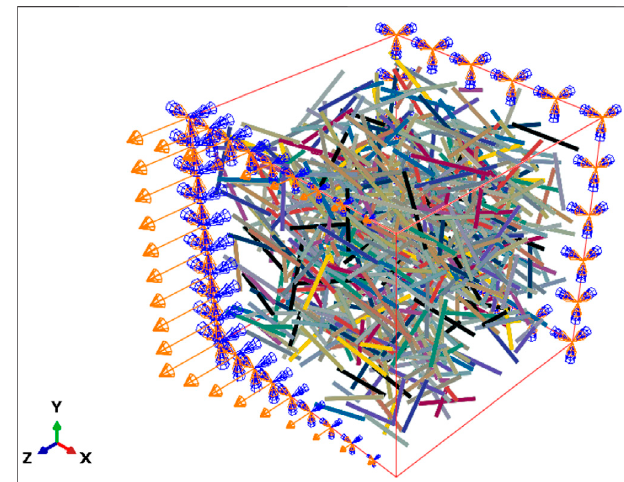
FIGURE 11 | Steel fi ber concrete mock-up